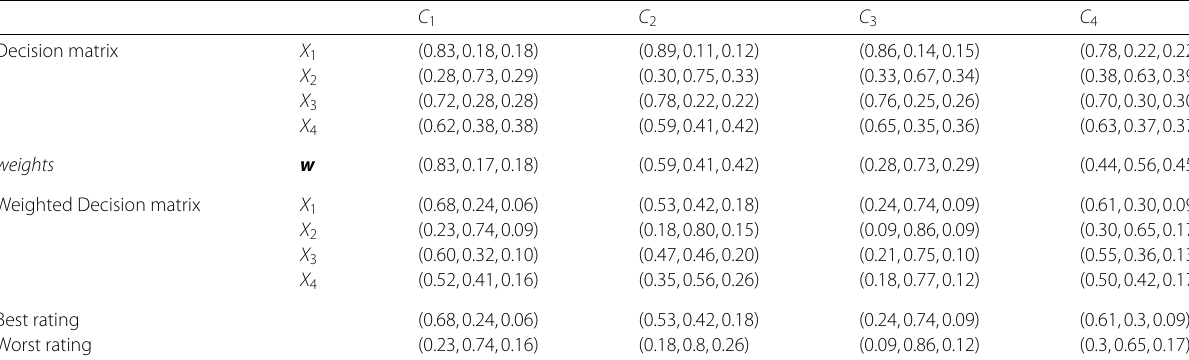
Table 1 The decision matrix, the weighted decision matrix, and the reference points C 1 C 2